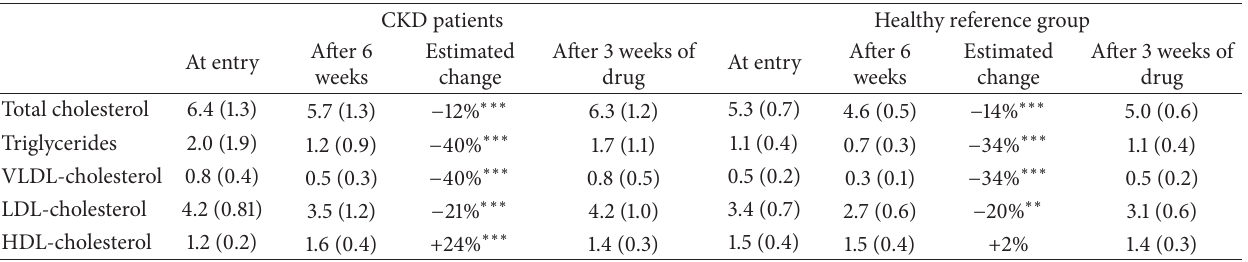
Table 2: Plasma lipid levels (mmol/L) in patients with chronic renal insufficiency ( n = 23) and healthy reference subjects ( n = 17) at start and end of treatment with 1mg tesaglitazar o.d. Mean and standard deviation (in parenthesis).